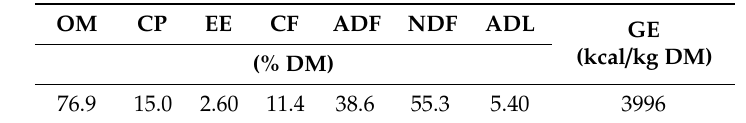
Table 1. Chemical composition of Cowpea fodder haulm ( Vigna unguiculata ), (Cowpea, var.58 / 74) used in the